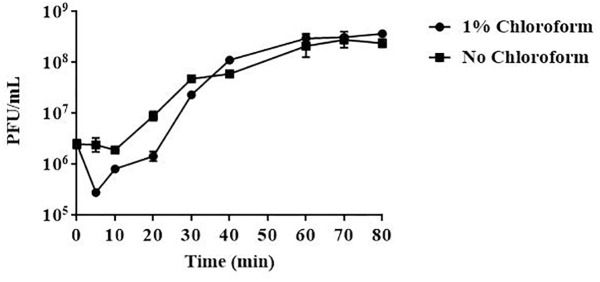
One-step growth curve of phage vB_EaeM_φEap-3. Phage vB_EaeM_φEap-3 was grown in an exponential phase culture of Enterobacter aerogenes strain 3-SP. Data points indicate the PFU/mL at different time points. Each data point represents the mean of three independent experiments.